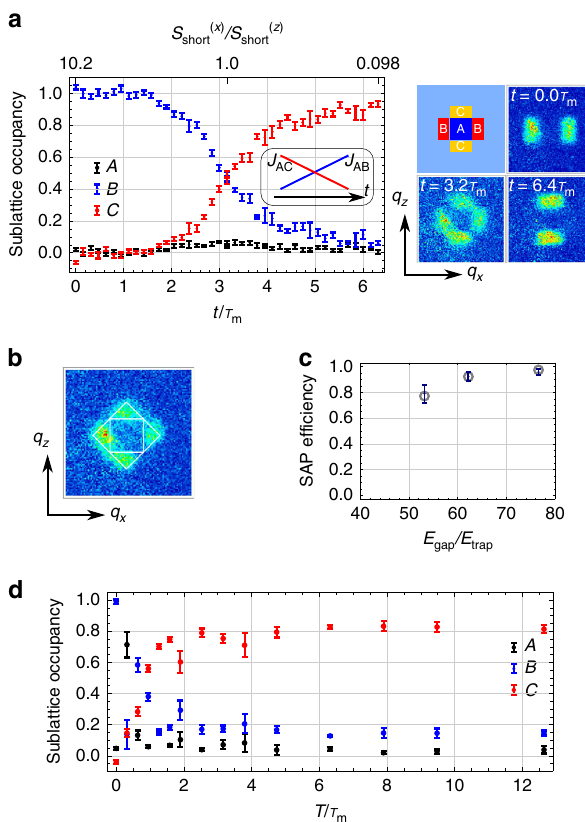
Fig. 2 Realization of spatial adiabatic passage. a Time evolution of sublattice occupancies N A , N B , and N C during a SAP process. Time is rescaled by τ m = 0.63 ms. Samples of absorption images of Yb atoms taken in the experiment are also shown in the right hand side, corresponding the distribution at the initial ( t = 0.0 τ m ), half ( t = 3.2 τ m ), and fi nal stage ( t = 6.4 τ m ) of the process. Inset shows the temporal change of the coupling parameters. Error bars represent standard deviation. b Band-mapping image at the half point of the SAP process ( a ). Boundaries for the fi rst and second Brillouin zone are indicated by white lines. c Dependence of SAP ef fi ciency on the ratio E gap / E trap . The gray circles represent the theoretical estimation with trap. Error bars represent standard deviation. d Adiabaticity of the SAP process. Sublattice occupancies after SAP are shown as a function of total sweep time T . Slightly low SAP ef fi ciency compared to that in ( a ) is attributed to the instability of the lattice phase ψ . Error bars represent standard